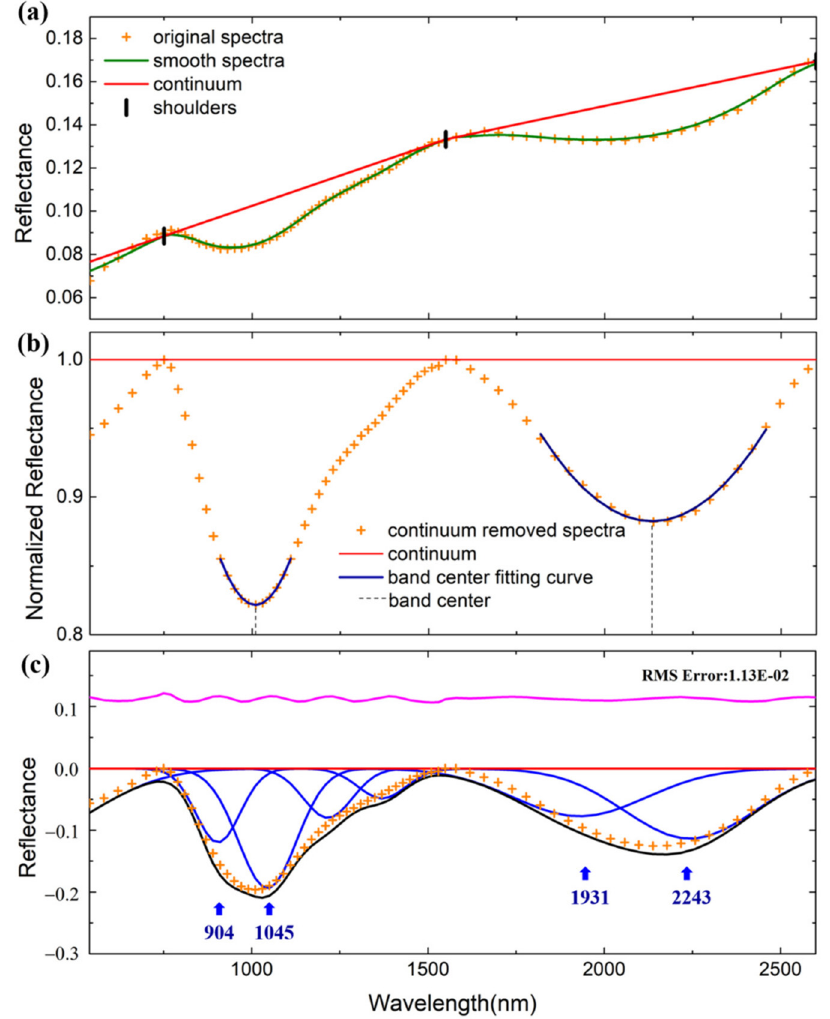
Figure 2. An example for M 3 spectral data processing. ( a ) The original spectrum (orange crosses) was smoothed (green line) and then shoulders (black vertical bars) were automatically detected. The linear segments connect the modeled continuum (red line). The spectrum after removing the continuum (red line of y = 1) is shown in ( b ) as orange crosses. The second-order polynomial fit curves (navy line) were used to calculate absorption band centers (vertical dotted lines) around 1000 and 2000 nm. ( c ) The MGM method employed the deconvolution of pyroxene absorption bands. From top to bottom: Root-mean-square (RMS) error (magenta line), continuum (red line), Gaussian absorptions (blue lines), continuum-removed spectrum (origin crosses), fitting spectrum (black line), and absorption bands of pyroxene (blue